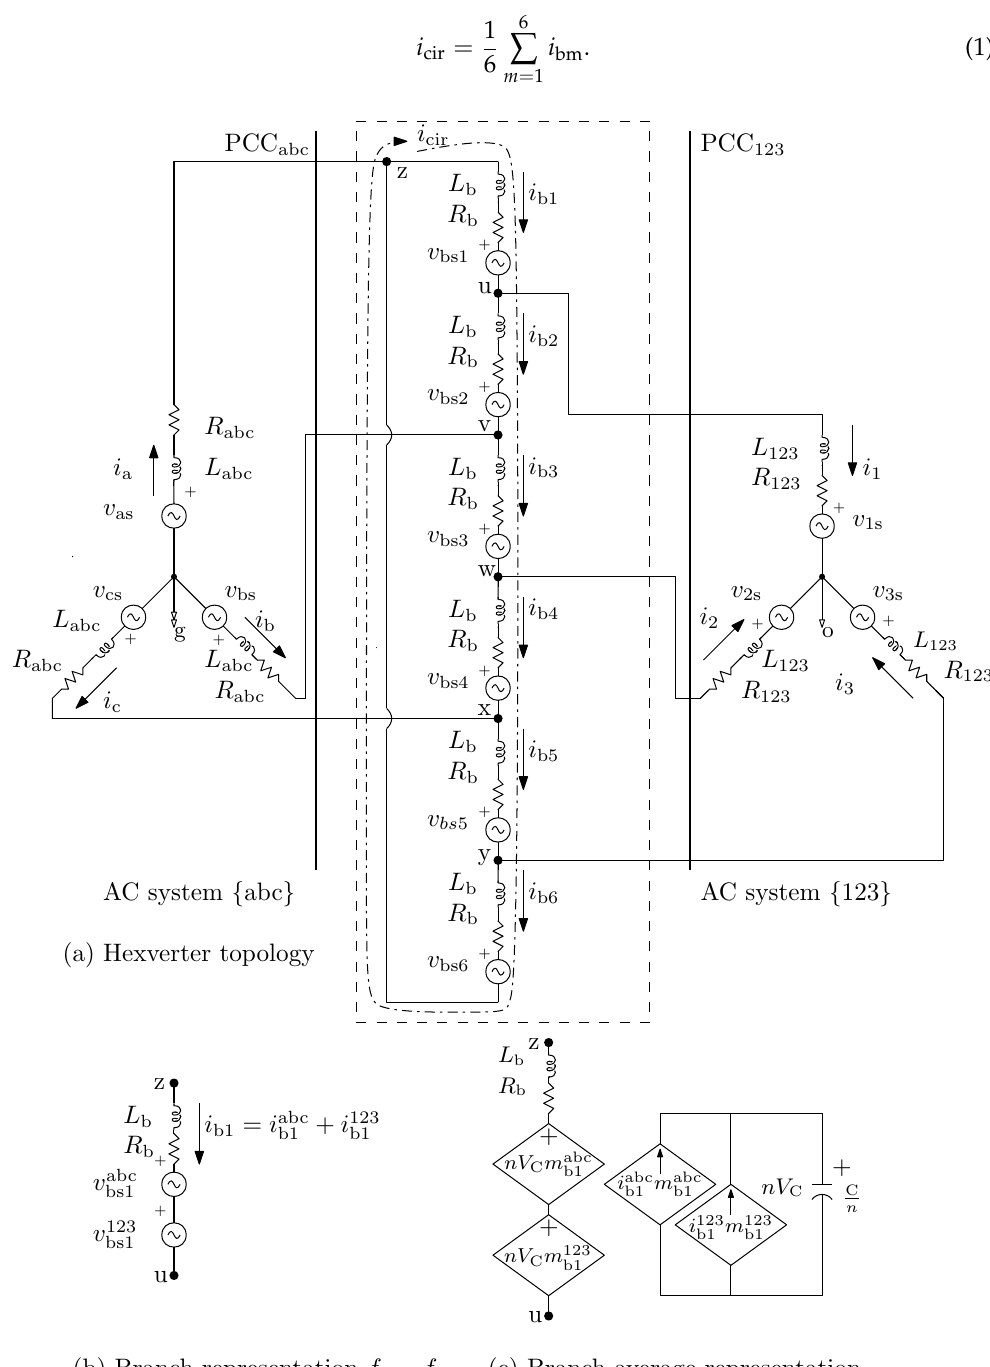
Figure 1. AC–AC Hexverter